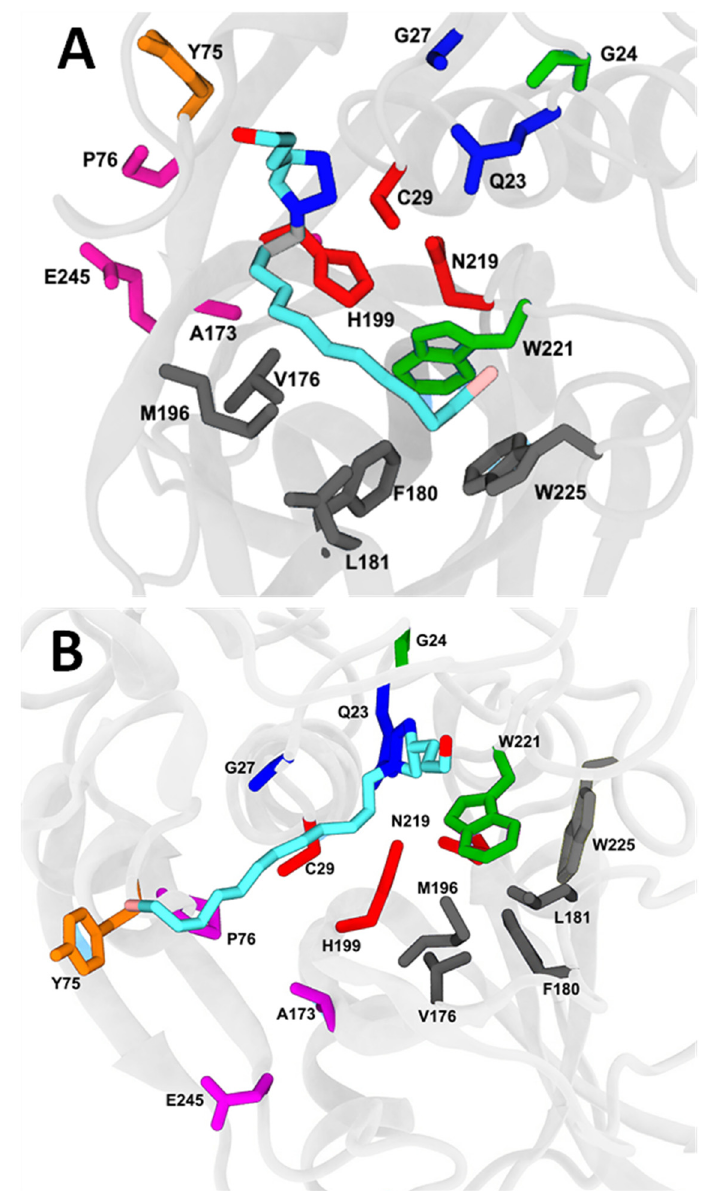
Figure 8. Molecular docking of cathepsin B with compounds C9 and C21 . ( A ) Cathepsin B- C9 complex. ( B ) Cathepsin B- C21 complex. Catalytic triad in red (Cys29, His199; Asn219). Amino acid subsites: S’3 in green (G24; W221), S’2 in black (M196, L181, V176, F180; W225), S1 in blue (Q23; G27), S2 in magenta (P76, H173; E245) and S3 in orange (Y75).